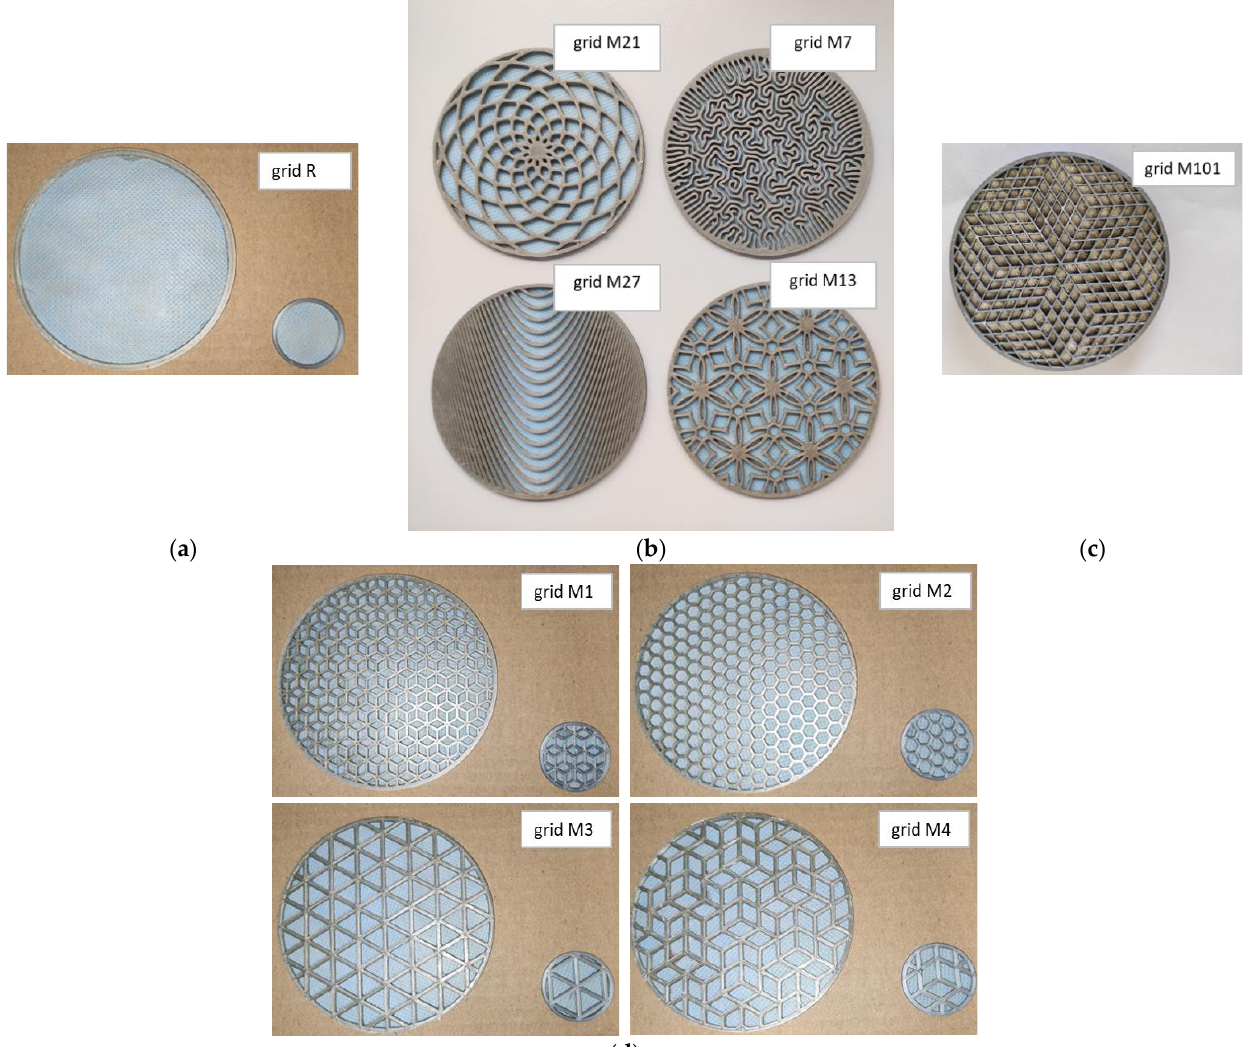
Figure 5. Images of selected samples of grid: ( a ) nanofibrous membrane in the ring R; ( b ) randomly selected patterns M21, M7, M27, M13; ( c ) grid filled with a bulky nanofibrous structure M101; ( d ) patterns with the best sound absorption coefficient M1, M2, M3, M4.